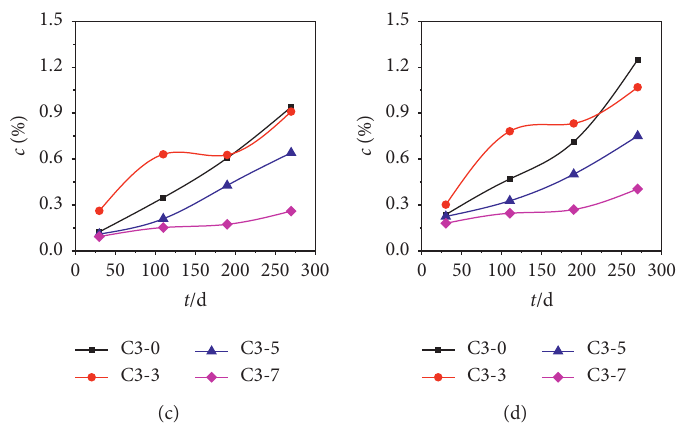
Figure 11: Variation of CIC with corrosion time for the concrete with 50% admixture after 0 (a), 30 (b), 60 (c), and 90 (d) freezing-thawing cycles.